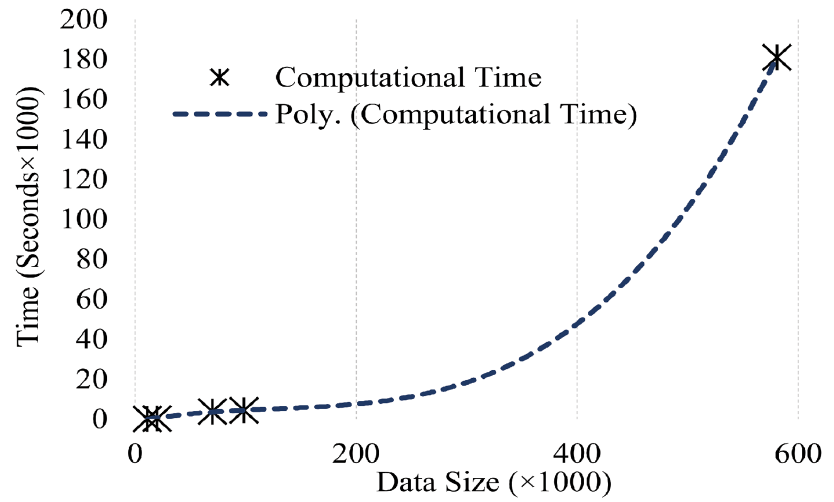
Fig 2. Computational time versus data size